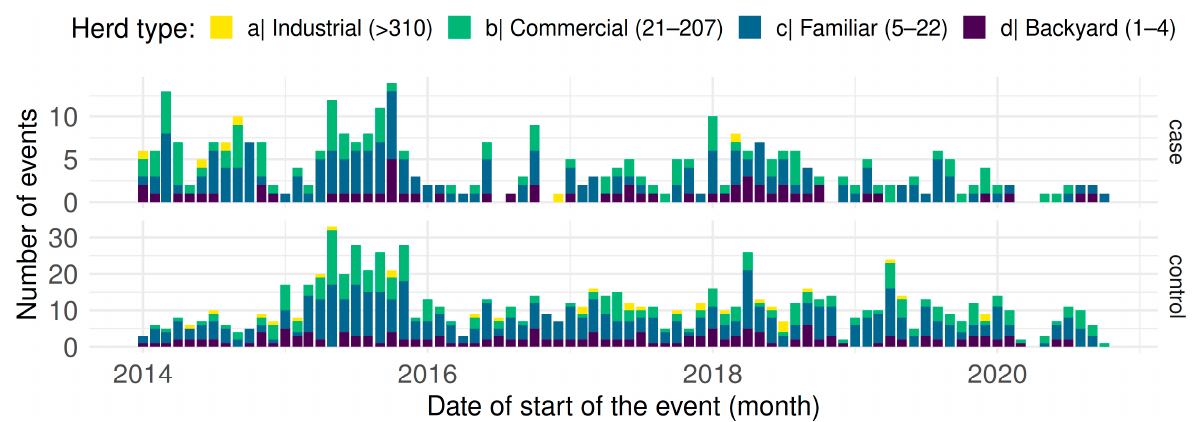
Figure 2. Distribution of events (cases and controls) reported between 2014 and 2020 in Ecuador; bars represent monthly counts, height and colours of bars according to the type of herd (different scales on the y-axis).